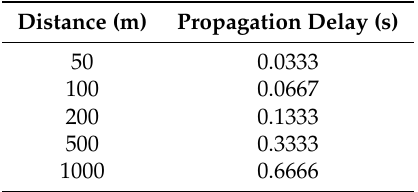
Table 1. Propagation